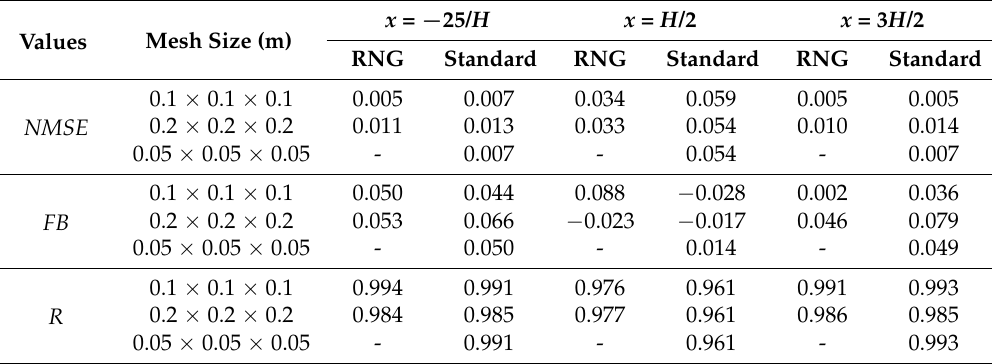
Figure 3. ( a ) Domain setup and grid arrangement in validation models; ( b – d ) vertical profile of U/U ref along lines at the center cross section of the building models. ( b ) x = −25/ H ; ( c ) x = H /2; ( d ) x = 3 H /2. Table 2. Statistical metrics for the validation cases.